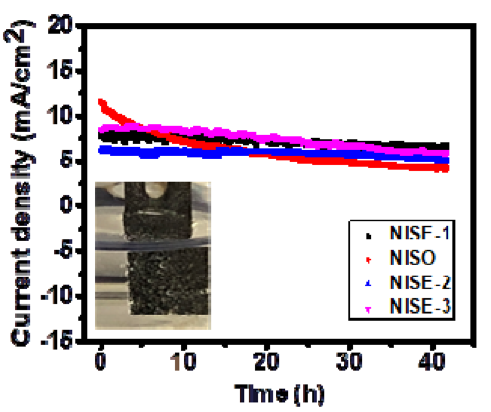
Figure 12. Stability performance of the electrodes using chronoamperometry (inset figure shows photographic image of oxygen evolution during this experiment from the NiS